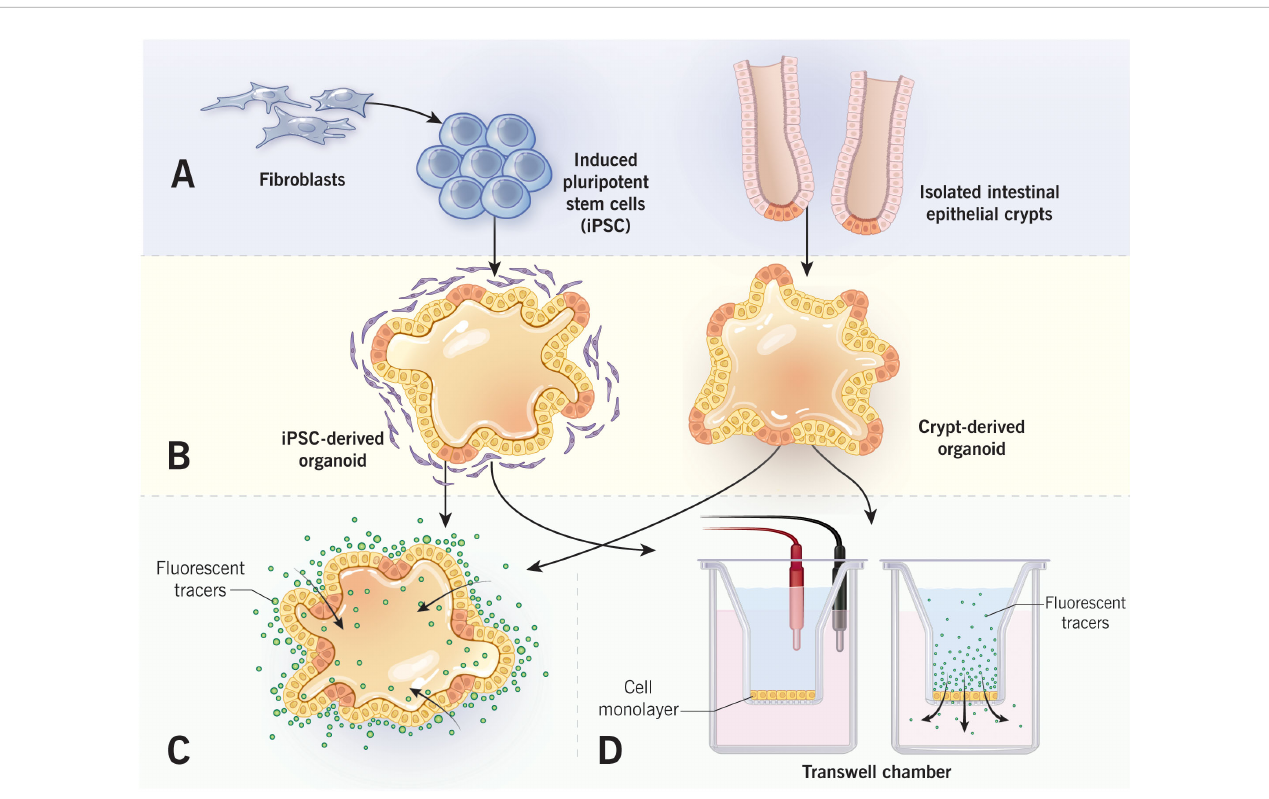
FIGURE 2 Measurements of epithelial barrier permeability in human intestinal organoids. Intestinal organoids that are derived from either induced pluripotent stem cells or isolated intestinal crypts (A) form cyst-like structure after embedding into 3-D extracellular matrix (B) . Epithelial permeability could be evaluated in a 3-D spherical organoids by monitoring the passage of fl uorescent markers into organoid lumen (C) . Alternatively, organoids could be cultured as 2- D epithelial monolayers in Transwell chambers (D) . Permeability of organoid-derived monolayers could be examined by measuring either transepithelial electrical resistance, or transmonolayer fl ux of fl uorescent markers. Figure 2 by Gwendolyn Fuller, MFA. Reprinted with the permission of the Cleveland Clinic Center for Medical Art & Photography © 2022. All Rights